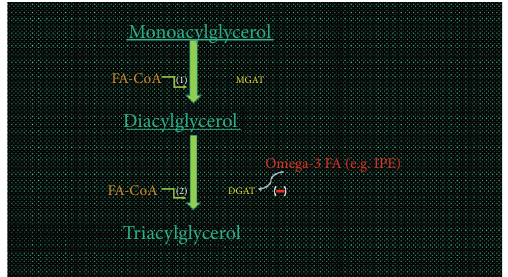
Figure 1: Triglyceride synthesis pathway and mechanism of action of omega-3 FA (fatty acid): In step (1), monoacylglycerol and FA- CoA combine to form diacylglycerol. This step is mediated by the MGAT enzyme. In step (2), diacylglycerol combine with another FA-CoA to form triacylglycerol, fi nal step in triglyceride synthesis pathway. This last step is mediated by DGAT enzyme. This enzyme is inhibited by omega-3 FA, including IPE. Abbreviations: FA-CoA: fatty acyl CoA; MGAT: monoacylglycerol acyltransferase; DGAT: diacylglycerol acyltransferase enzyme; IPE: icosapent